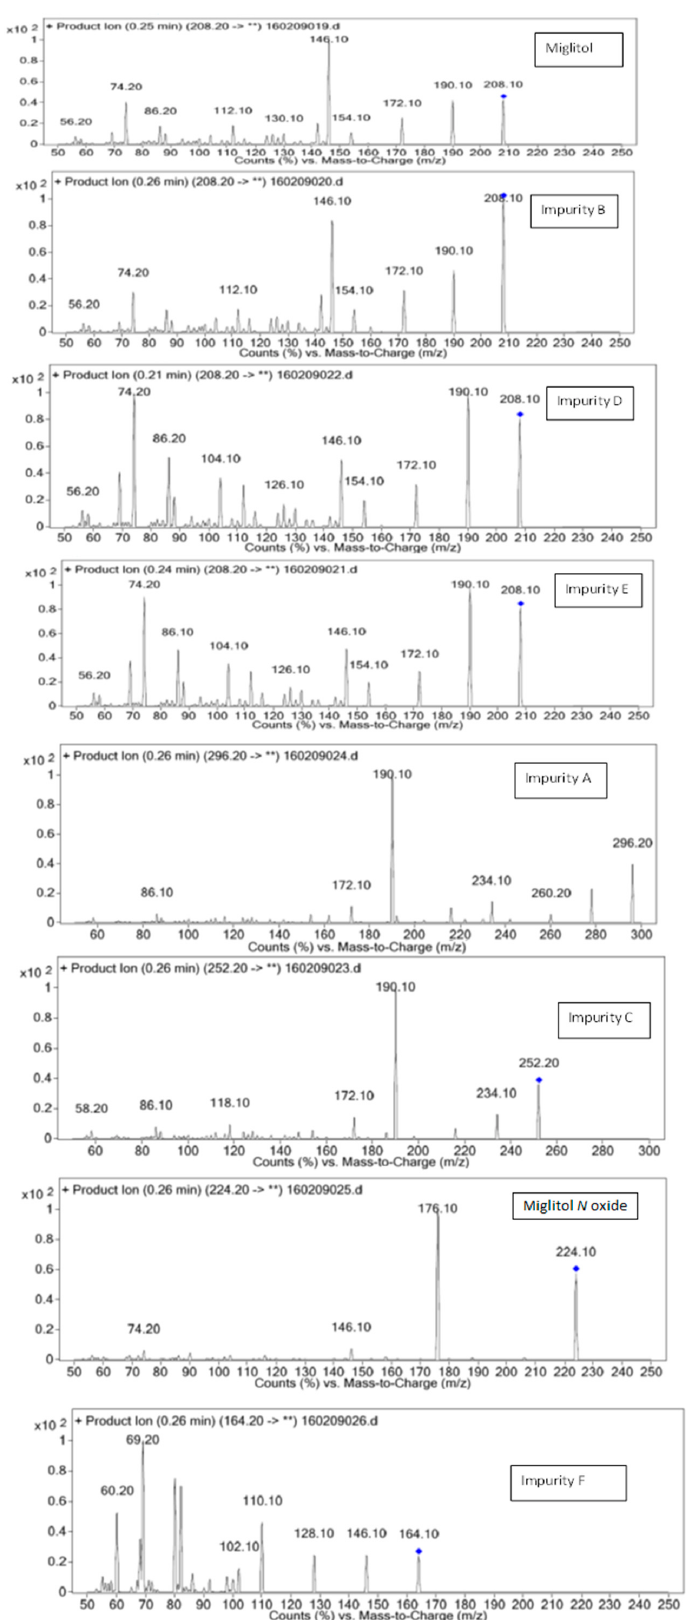
Figure 3. Fragmentation spectral data for miglitol and its